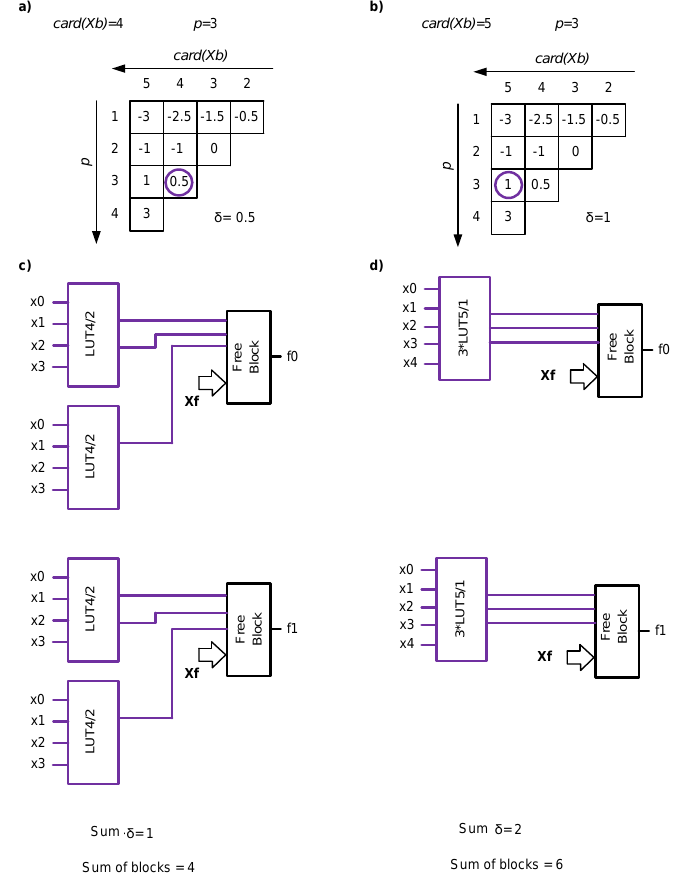
Figure 4. Triangle tables and gained structures (without considering blocks’ sharing); ( a ) a triangle table for card ( X b ) = 4, ( b ) a triangle table for card ( X b ) = 5, ( c , d ) gained